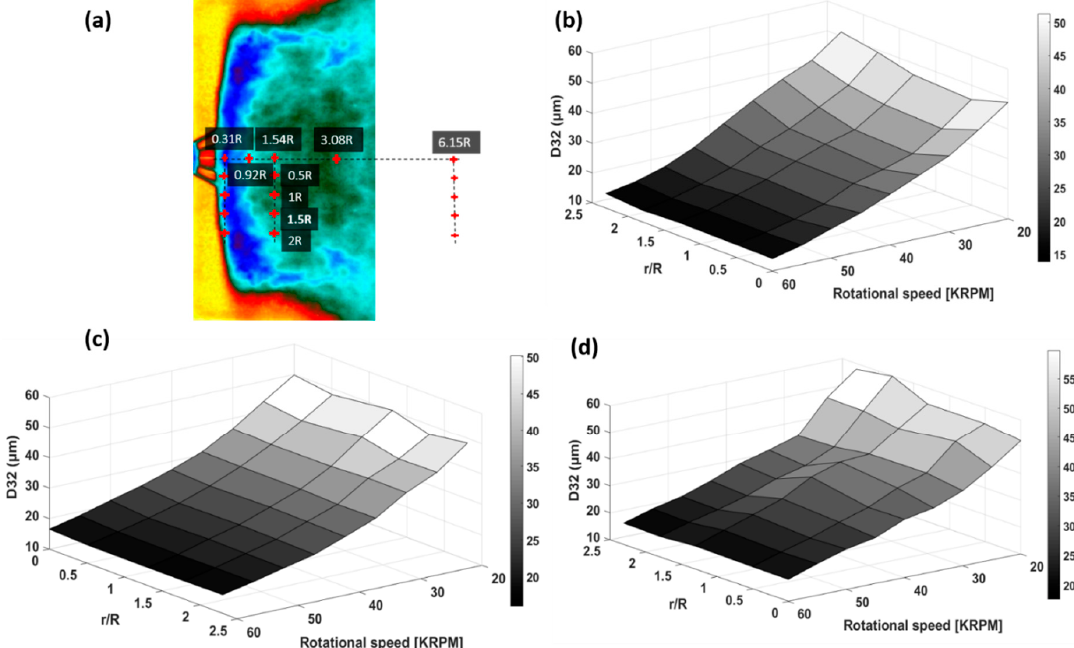
Figure 9. The variation of the D 32 for a fluid flow rate of 350 ccm and varying the rotational speed of the ERBS at different vertical locations within the spray flow field.